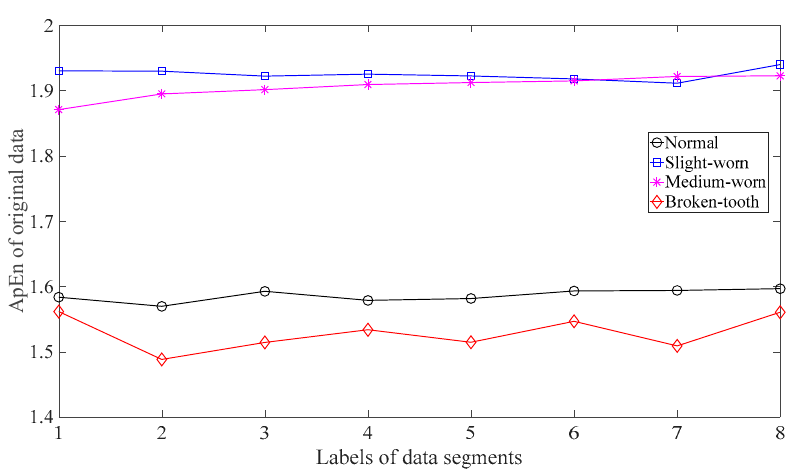
Figure 5. Kurtosis of the four types of gear vibration data.